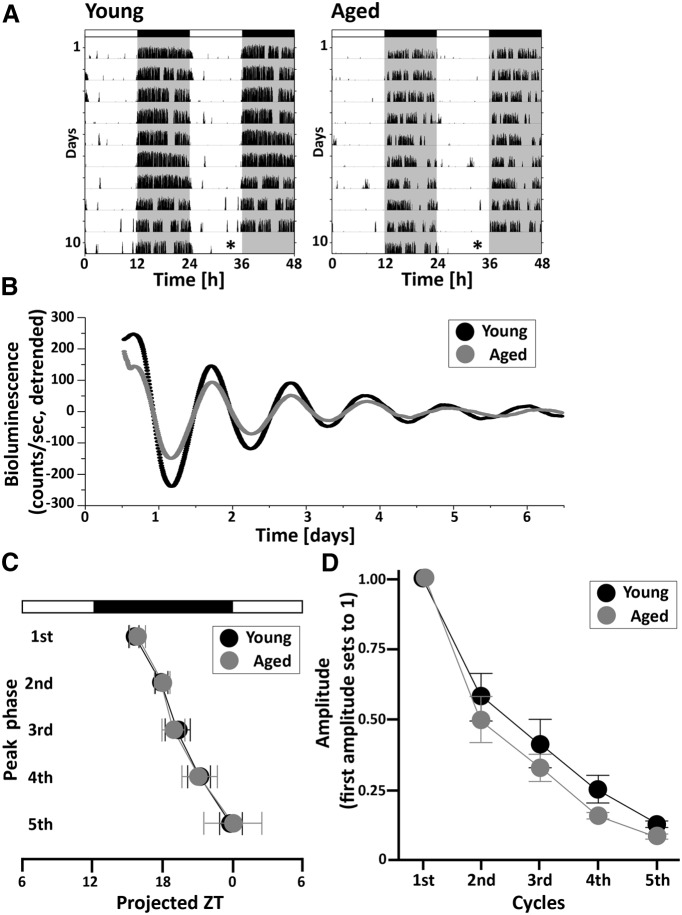
Effects of aging on PER2::LUC rhythms in SCN explants from mice maintained under LD cycles. A, Representative double-plotted actograms of wheel-running activity in young and aged PER2::LUC mice maintained under LD cycles. Lighting conditions are indicated at the top of the figure; open bars indicate light phases, and closed bars indicate dark phases. Asterisks indicate the timing of the killing of the animals. B, Typical examples of the PER2::LUC rhythm of SCN explants from mice maintained under LD cycles, as measured by PMT. C, Phase map of peak PER2::LUC rhythms in the SCN. Each point represents the average peak of PER2::LUC rhythms in each cycle, plotted relative to the LD cycle prior to the killing of the animals. D, Amplitude of PER2::LUC rhythms in the SCN. The amplitude of each oscillation was determined as the sum of the absolute values of the lowest and highest points (counts). Data are shown as the mean ± SD. n = 5 per group.